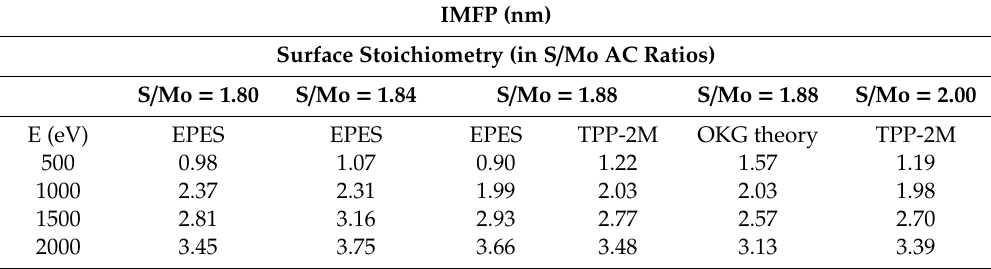
Table 1. The IMFP values (in nm) determined from EPES for Mo disulfide flakes with different surface stoichiometries, the IMFPs estimated from the TPP-2M formula (Equation (2)) [19], and the IMFPs calculated from the OKG theoretical model [21] for the indicated disulfide surface stoichiometries. IMFP